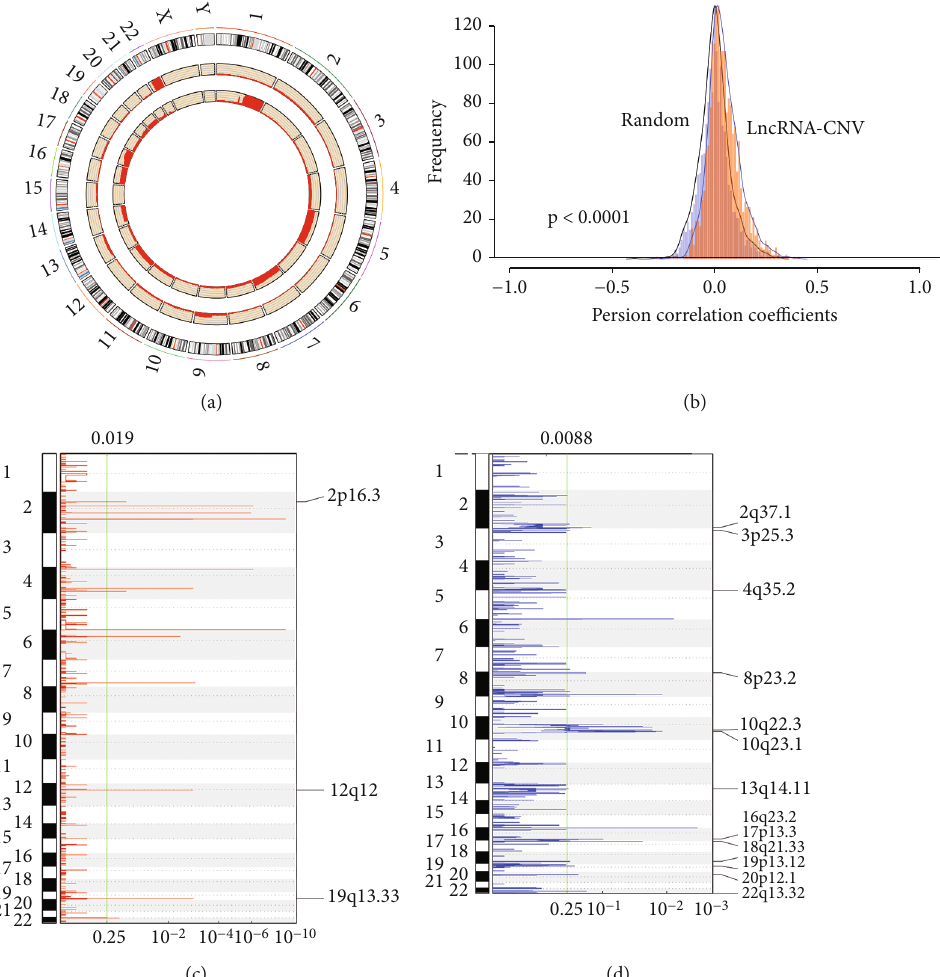
Figure 5: Identi fi cation of lncRNAs driven by CNV. (a) Distribution of lncRNA copy deletions and ampli fi cation in the genome. (b) Correlation distribution of CNV and expression of lncRNAs: light red represents the distribution under actual conditions, light blue represents the distribution under random conditions, and the di ff erence between the two distributions is assessed by the T-test. (c – d) LincRNAs located in the focal CNA peaks are THCA-related. False-discovery rates ( q values) and scores from GISTIC 2.0 for alterations ( x -axis) are plotted against genome positions ( y -axis); the dotted lines show the centromeres. The deletions (right and blue) and ampli fi cations (left and red) of lincRNA genes are presented. The green line shows 0.25 q value cuto ff point that determines signi fi